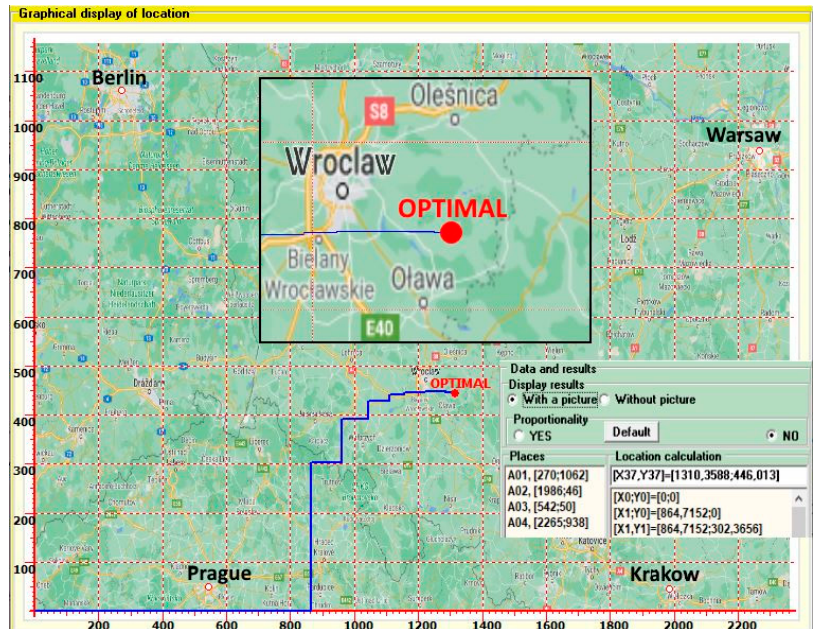
Figure 10. Results of the calculation of the location of the point on the area in the proposed expert system.